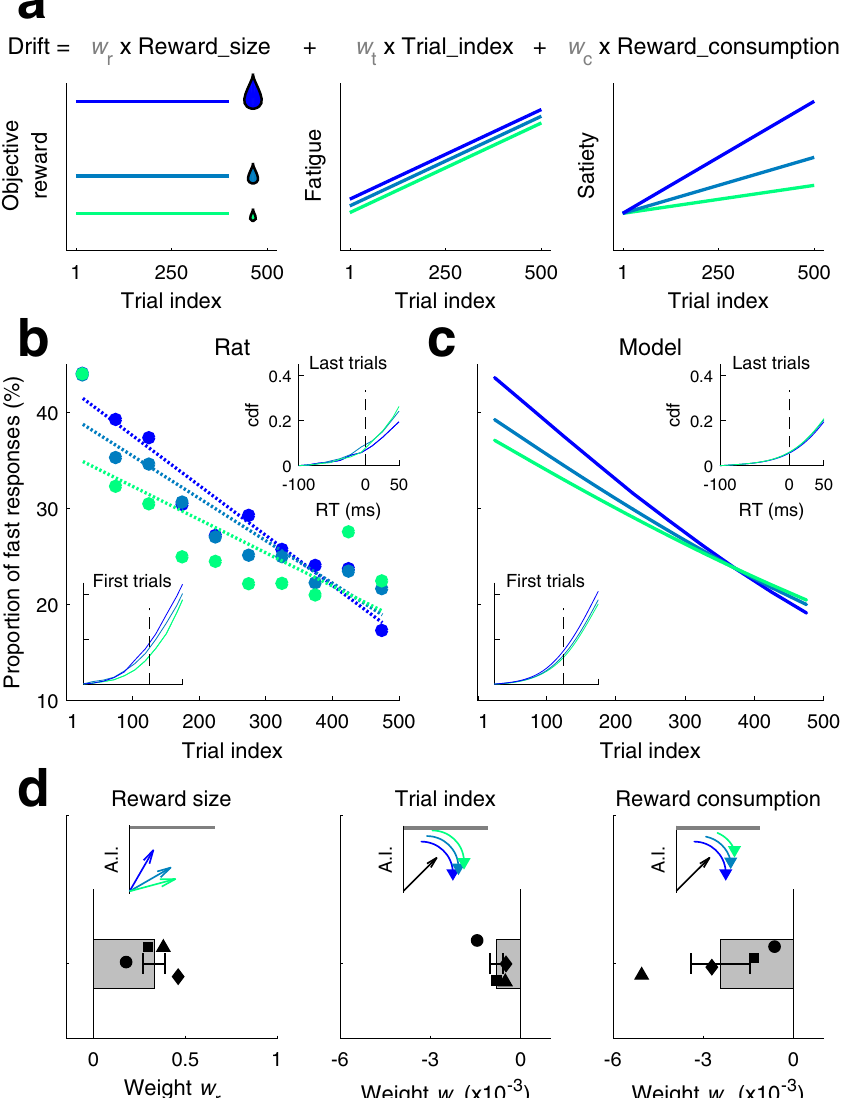
Fig. 7 Internal factors impacting RTs. a Reward size (left), fatigue (center), and satiety (right) as a function of trial position within session for low (green), middle (light blue), and high (strong blue) reward size sessions. Color code is shared for all panels ( a – d ). Top equation illustrates the implementation in the model of these three features as linear regressors in AI drift, with w r the weight for reward size, w t for fatigue, w c for satiety, and w 0 for the intercept. b Proportion of rat ’ s fast responses (faster than 50 ms after stimulus onset, or fi xation break) as a function of trial position within session and reward size, for an example animal (rat #54). Dashed lines: linear fi ts. Insets: RT cumulative distribution for trial block 51 – 100 (bottom left) and 451 – 500 (top right); vertical dashed line: stimulus onset. c Proportion of fast responses simulated using PSIAM fi t to the RTs of the example rat in panel ( b ). Insets: same as in ( b ), but simulated using PSIAM. d Estimated weight for reward size (left), trial index (center), and reward consumption (right) regressors in AI drift. Bars: mean across animals (Group 4, n = 4); symbols: individual rats; error bars: s.e.m. Source data are provided as a Source data fi